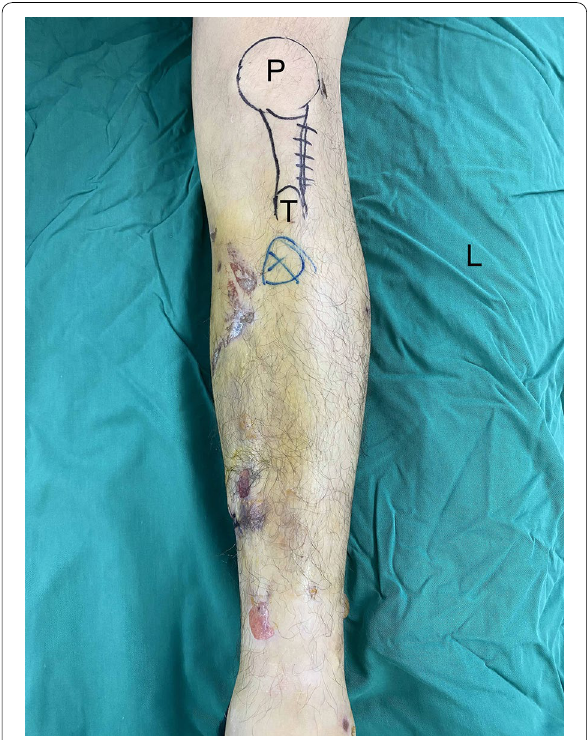
Fig. 2 Skin incision during the SEIP technique. SEIP semi‑extended infrapatellar, P patella, T tibial tuberosity, L